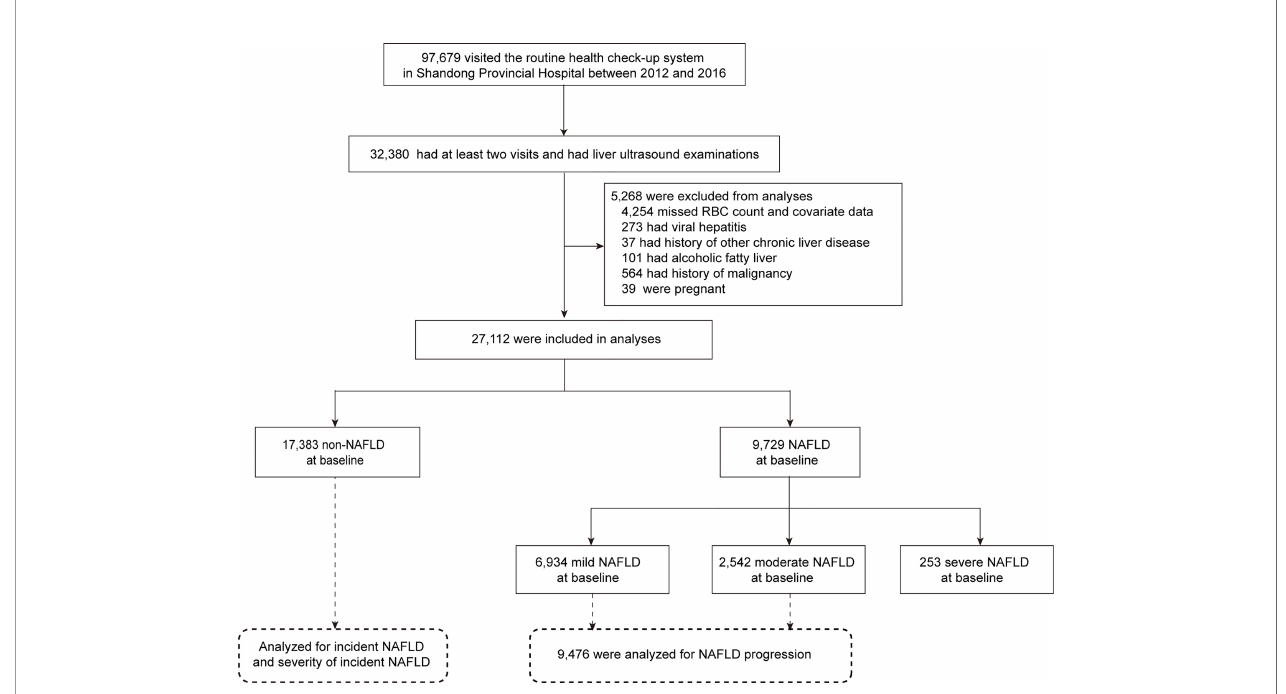
FIGURE 1 | Participant fl ow